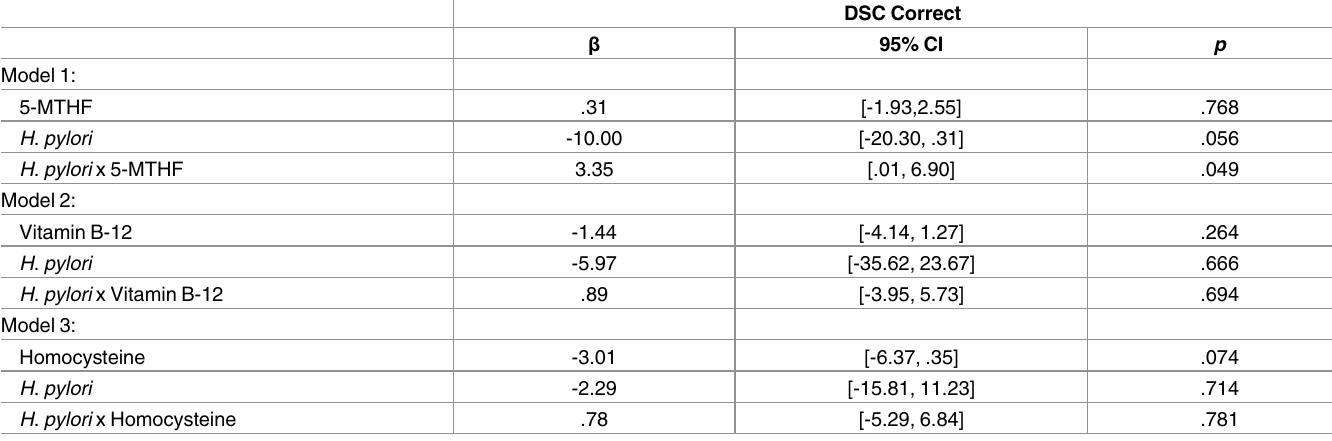
Table 3. Two-way interaction effectsof folate cycle factor concentrations and Helicobacter pylori infection status predicting cognitive function in U.S. 60 to 85-year-olds.